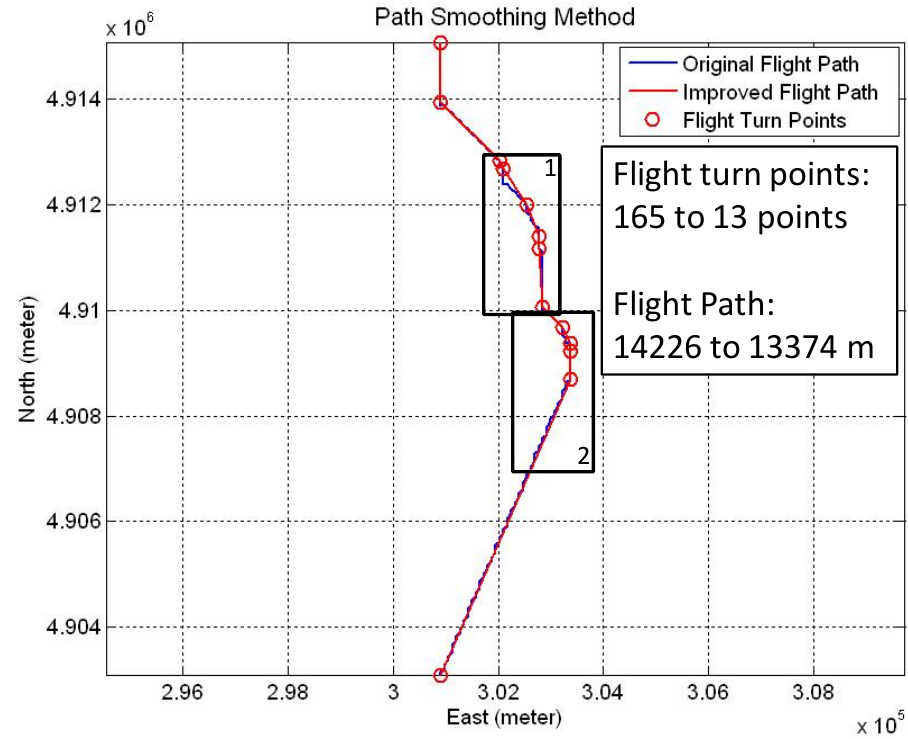
Figure 9. The flight turn points are decreased from 169 to 13 points and the route is shortened from 14.6 km to 13.7